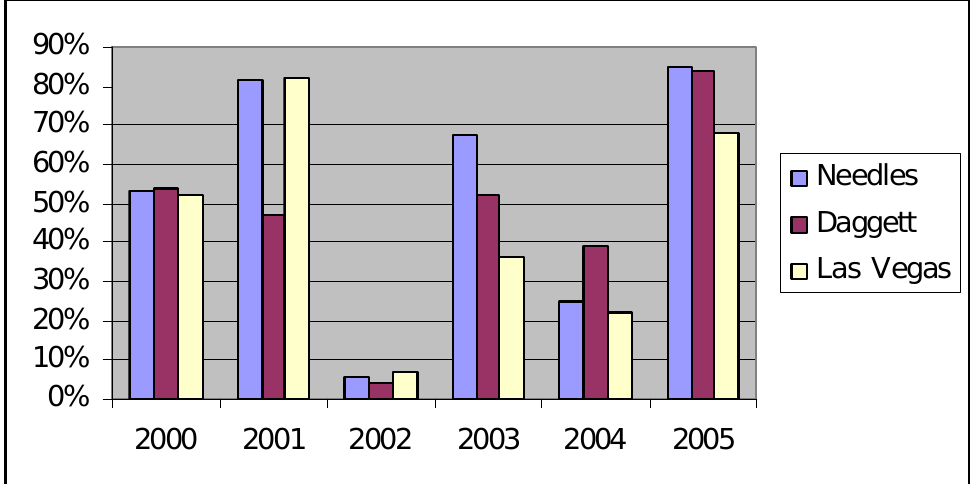
Figure 3. Percentage of yearly precipitation that occurred during January, February, and March of 2000 through 2005 at three weather stations in the Mojave Desert. Little precipitation fell in 2002 during the critical establishment season for annual plants. In contrast, 2005 had a large percentage of the annual precipitation falling during the critical establishment season for annual plants at all three stations. (Data source: Western Regional Climate Center,